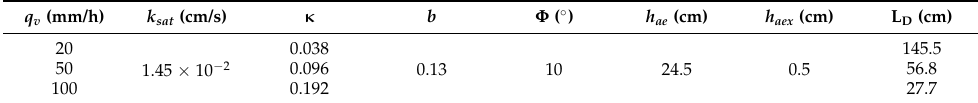
Table 6. Input parameters and results of the diversion length estimation done by applying Equation (2).